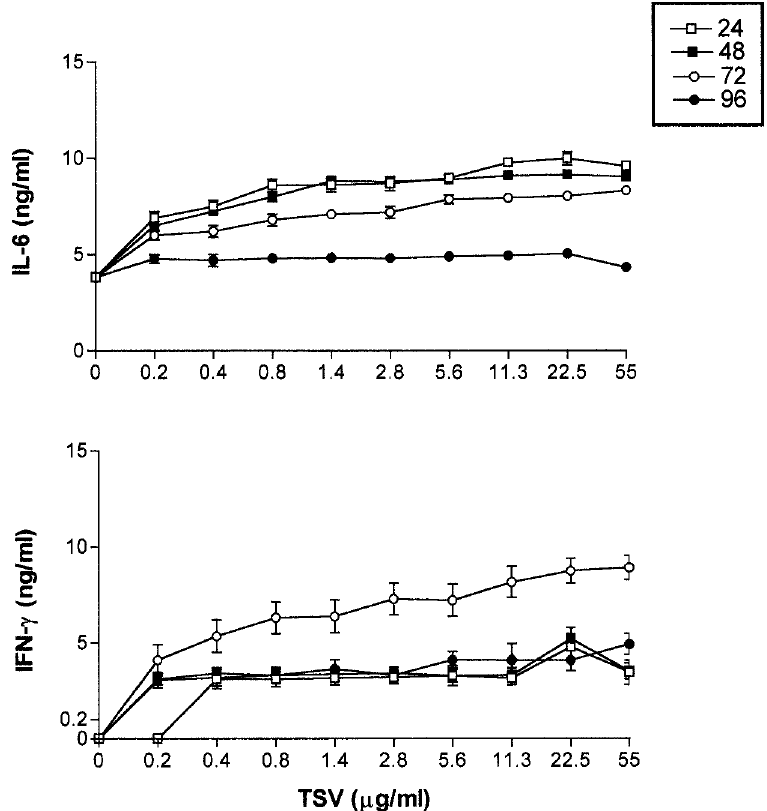
FIG. 2. Cytokine released by peritoneal macrophages from BALB/c mice. Peritoneal macrophages were obtained and stimulated in vitro as described in Fig. 1. IL-6 and IFN- g were assayed by ELISA assay using monoclonal antibodies as the probe. Each point represents the mean ± standard deviation value of samples from five experiments in different groups of five